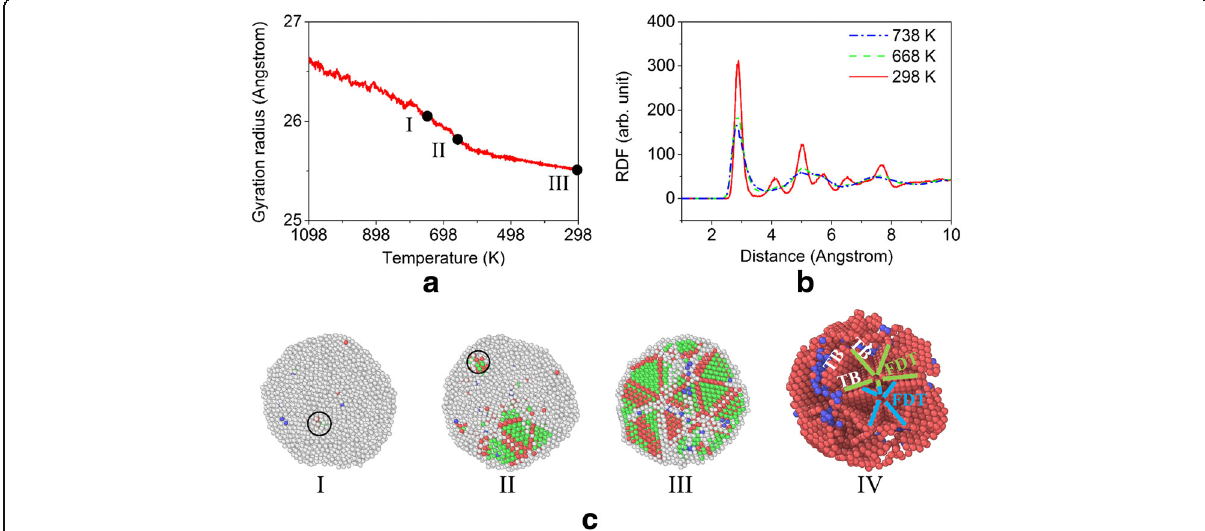
Fig. 4 Evolution of the gyration radius, radial distribution function, and the nanostructure during the cooling process. a Gyration radius as a function of temperature during the cooling process and b the corresponding radial distribution functions (RDF) of the system at 738, 668, and 298 K. c Sectional view of the nanostructures at I 738 K, II 668 K, and III 298 K, and IV the nanostructure of the final sintered product, in which circles indicate the nucleation cores. In addition, disordered and FCC atoms are removed, and two fivefold deformation twins (FDT, five short lines with the same color are used to represent an FDT) and several twin boundaries (TB) are marked in ( IV ) for